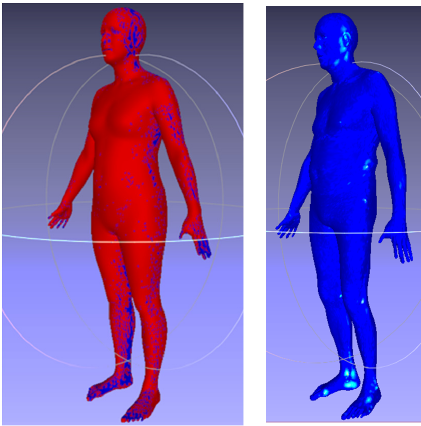
Figure 4. The 2D–3D reconstruction accuracy. The left image shows visible (red) vs. invisible (blue) vertexes in the template body. The right image shows the distribution of the reconstruction error, according to the ‘jet’ colormap (blue = 0.0 mm and red = 1.00 mm) in a sample body.